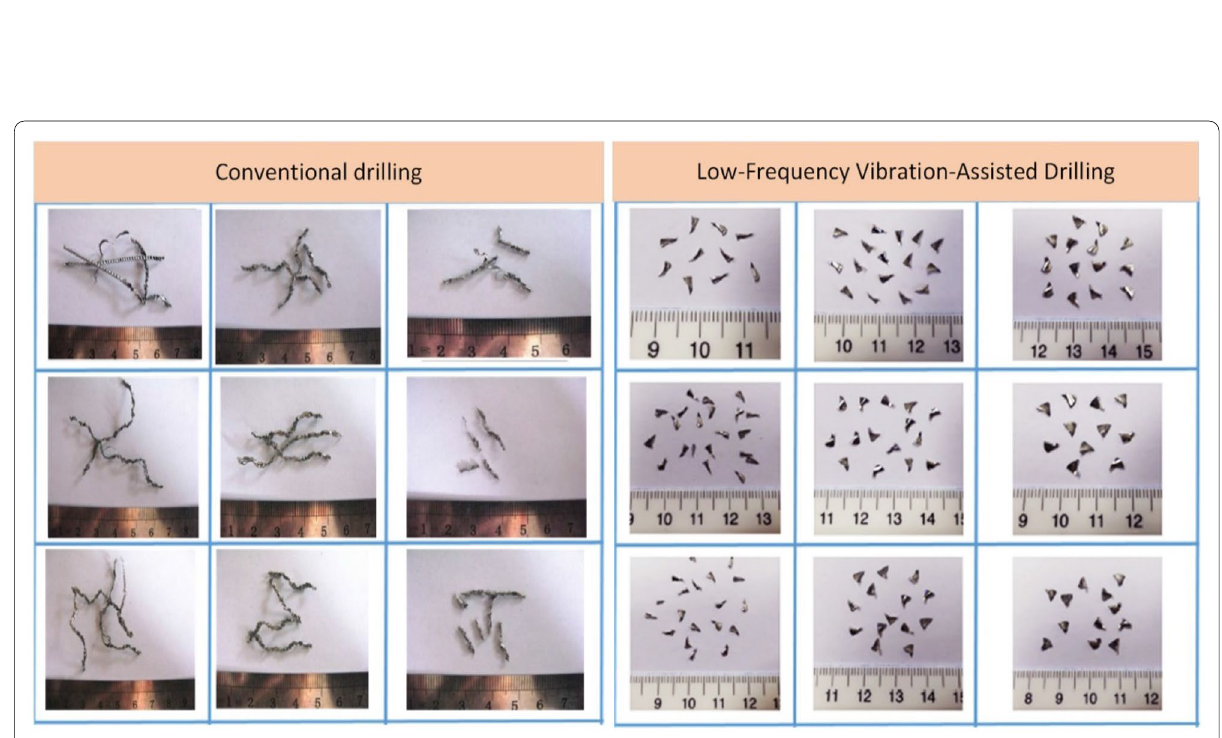
Figure 21 Chip morphology in conventional drilling and LFVAD [110,